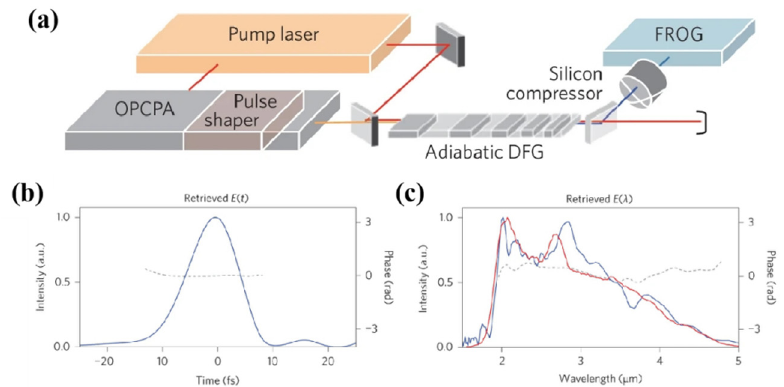
Figure 22. ( a ) A chirped adiabatic frequency conversion scheme employed the uncompressed broad- band output of a near-IR OPCPA mixed with a longer-wavelength picosecond pump pulse in a periodically poled quasi-phase-matching grating, a bulk silicon post-compressor and a frequency- resolved optical gating (FROG) characterization device. Measurement of a single-cycle MIR pulse. ( b ) Retrieved pulse as a function of time (blue, temporal intensity; gray, temporal phase) showing a 10.7-fs full-width at half-maximum (FWHM) pulse duration (1.2 optical cycles at the central wavelength of 2.8 µ m), which is 1.15 times the transform-limited duration. ( c ) Spectral intensity (red, measured; blue, retrieved) and retrieved spectral phase (gray). Reprinted with permission from [69].